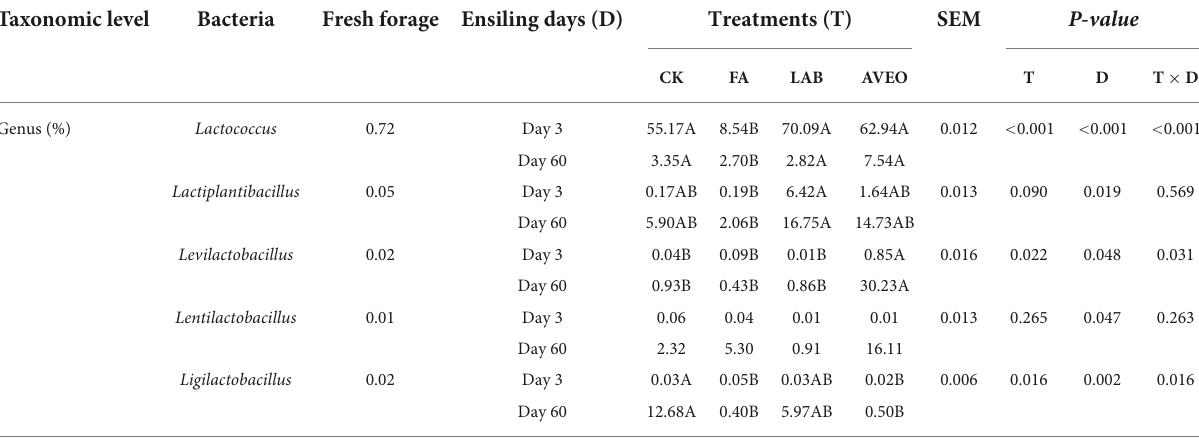
TABLE 4 Changes in all dominant LAB in silages at the genus level. Taxonomic